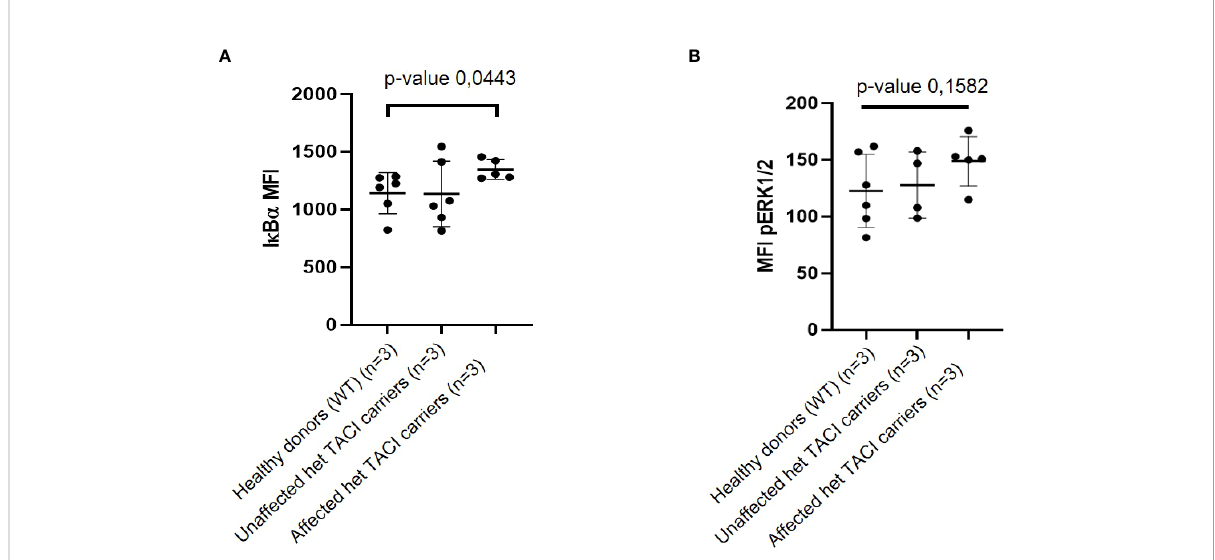
FIGURE 7 I k B a and pERK expression in unstimulated naïve B cells from TACI mutation carriers. (A) Mean fl uorescence intensity (MFI) of I k B a in naïve B cells from affected and unaffected TACI mutation carriers and healthy donor. (B) Mean fl uorescence intensity (MFI) of pERK in naïve B cells from affected and unaffected TACI mutation carriers and healthy donor. p -values (* p < 0.05) derived from unpaired t -test calculated with GraphPad Prism